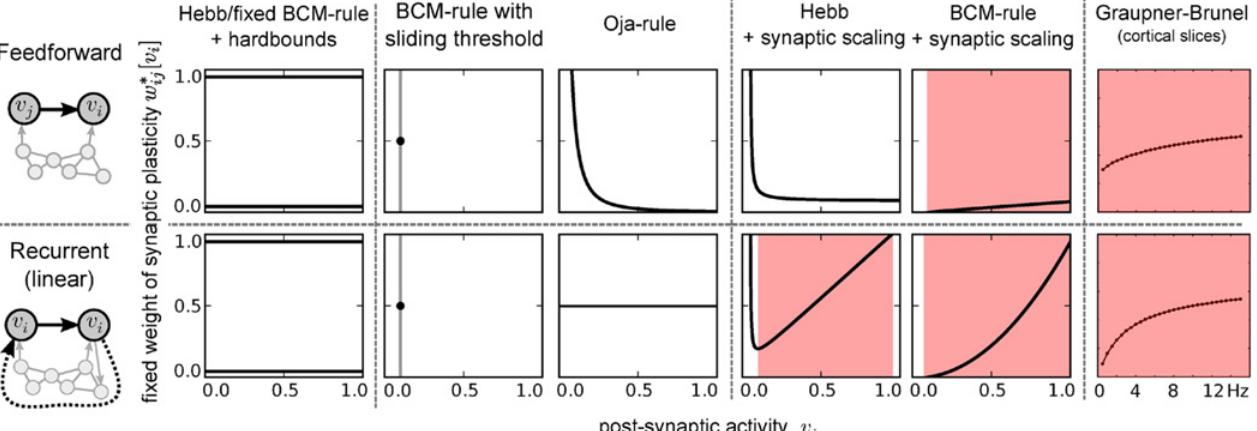
Figure 3. Most of the commonly used rate-based learning rules do not provide a positive correlation between weight and postsynaptic activity. The slope of the p d -term in Equation 2 is determined by the slope of the fixed weight depending on postsynaptic activity ( v (cid:2) i (cid:4) w (cid:2) ij relation) resulting from the synaptic plasticity rule. Here we show the v (cid:2) i (cid:4) w (cid:2) ij relation of commonly used learning rules [18] for the simple feedforward system (top row) and for a linear approximation of a feedback system, where the presynaptic activity equals the postsynaptic activity (bottom row). For reproducing experimental data, p d has to grow, i.e. the fixed weights have to increase with postsynaptic activity. This is fulfilled (red shaded area), for example, by the BCM-learning rule with synaptic scaling or a Hebb-like learning rule with synaptic scaling and feedback but also for more biological rules like the calcium-based plasticity rule from [24] (see Materials and Methods for parameters used to generate this figure).